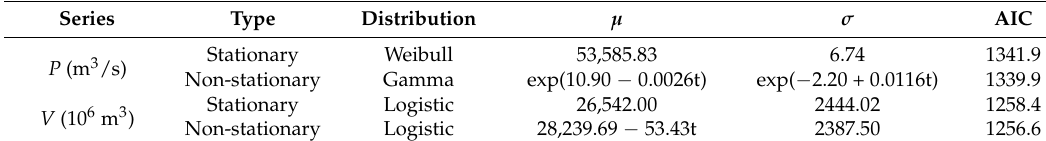
Table 3. The optimal marginal distributions and their parameters.